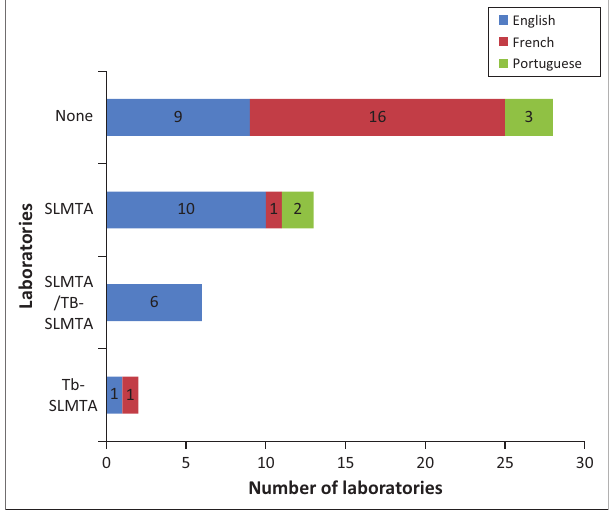
FIGURE 3: Auditing of National Tuberculosis Reference Laboratories in the World Health Organization’s African Region † using the Stepwise Laboratory Quality Improvement Process Towards Accreditation (SLIPTA) checklist, date of last audit and SLIPTA star grading achieved at last